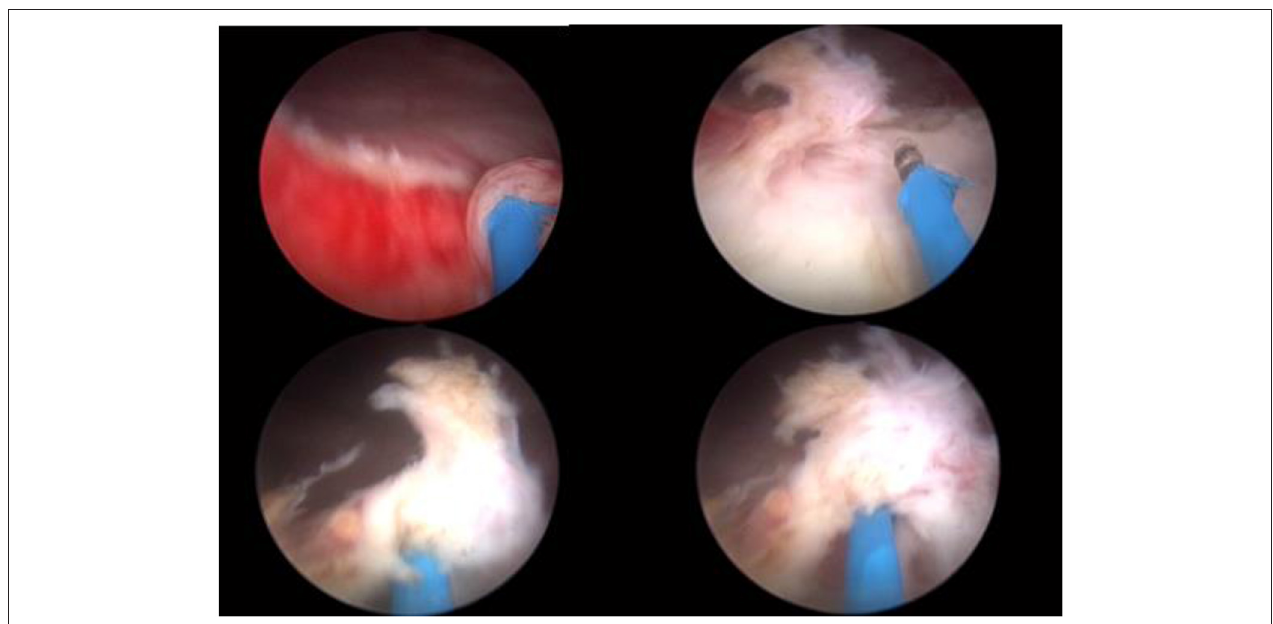
FIGURE 4 | Operation procedure.